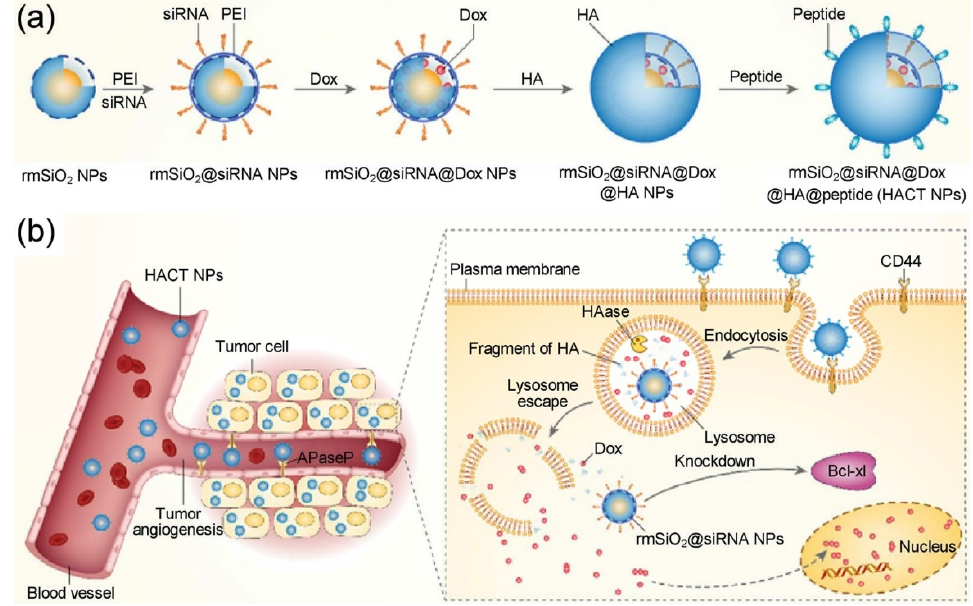
Figure 4. Schematic representation of: (a) construction of rattle-MSNs (rmSiO 2 NPs) coated with PEI and hyaluronic acid (HA) through “layer-by-layer assembly” strategy, loaded with doxorubicin and siRNA and functionalized with cell-penetrating peptide; (b) mechanism of selective controlled release guaranteed by the cascade of targeting moieties (cell-penetrating peptide and HA) and triggered by hyal-1. Reproduced with permission from ref. [229]. Copyright 2016, Springer Nature.